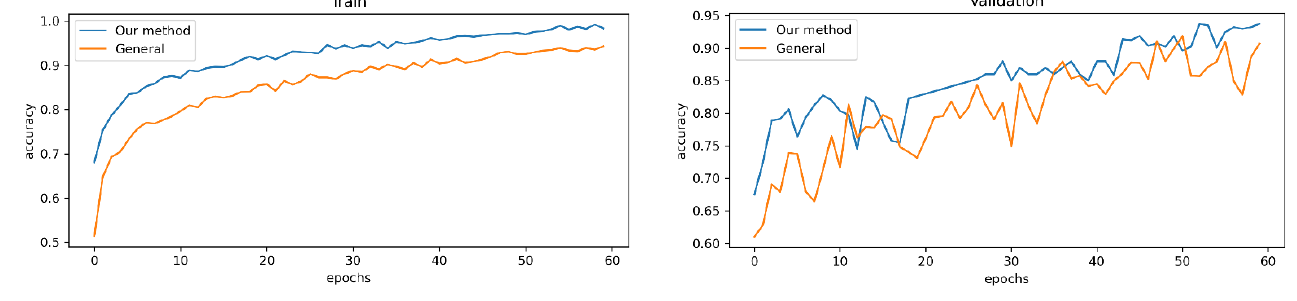
Figure 7. Data augmentation training and validation results.